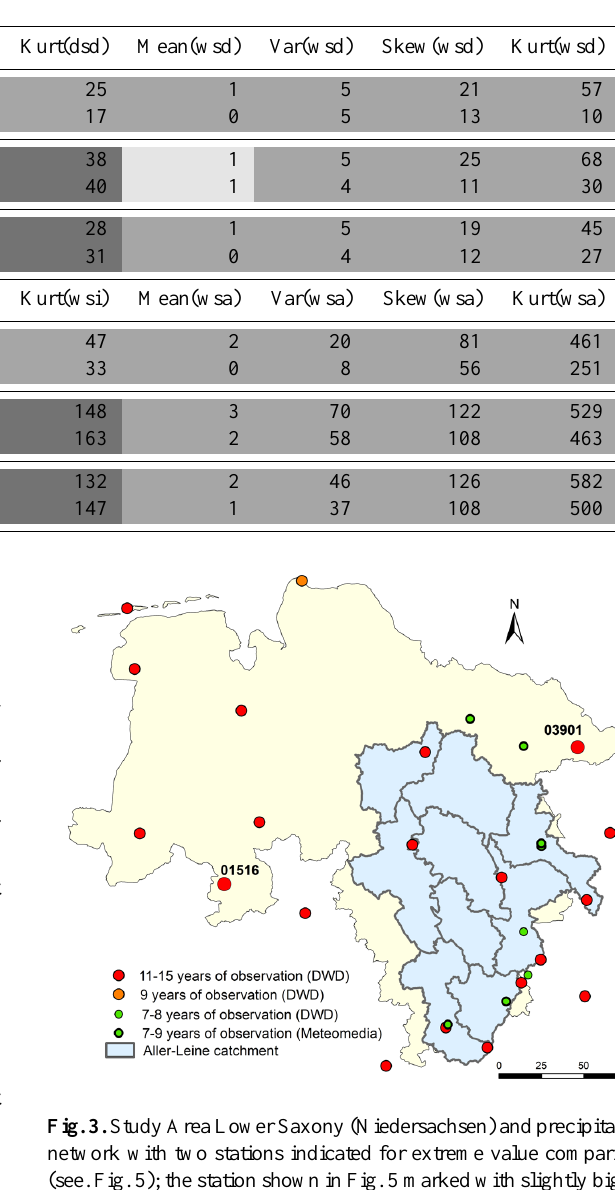
Table 2. Percentage deviation between observed and simulated statistical moments with and without using CPs as mean values over all stations (Var-Variance; Skew-Skewness, Kurt-Kurtosis); grey indicates an improved and dark grey a reduced accuracy through using CPs; light grey indicates when no changes occurred.